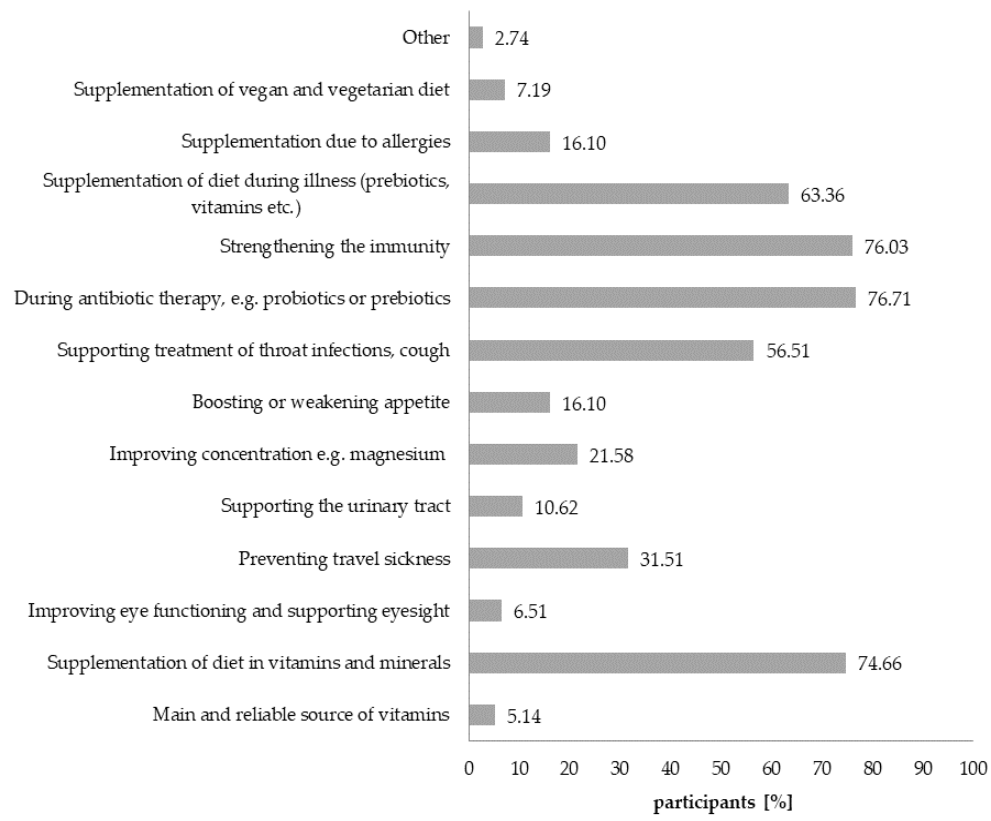
Figure 5. Reasons for administering dietary supplements to children. Values do not add up to 100%, due to the fact that more than one answer was allowed.